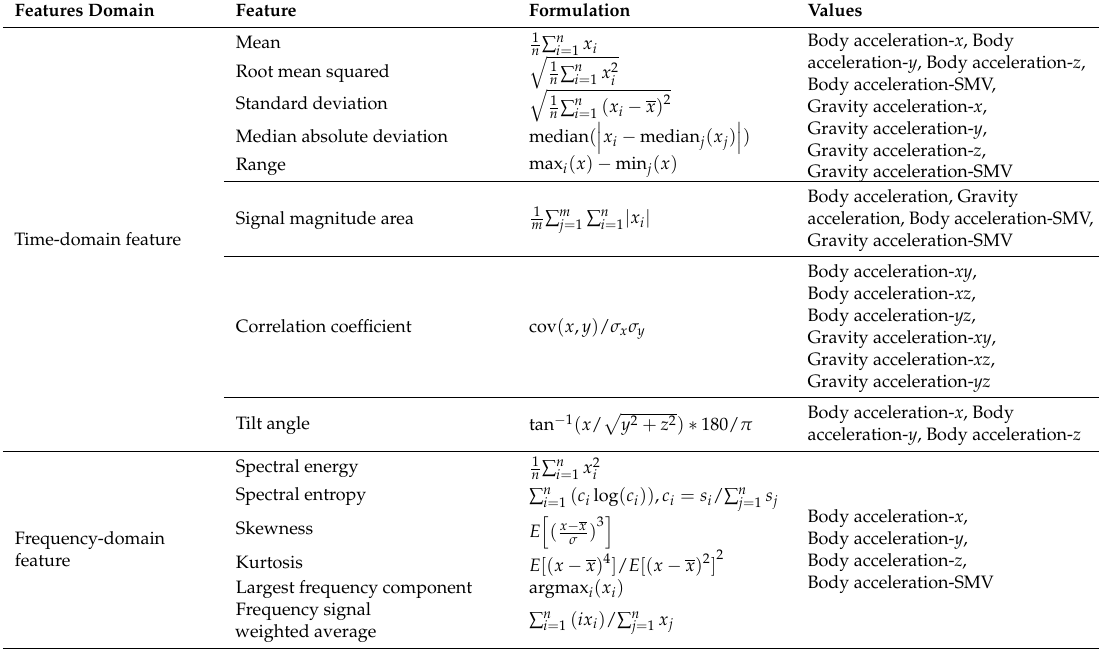
Table 2. Features extracted from both time domain and frequency